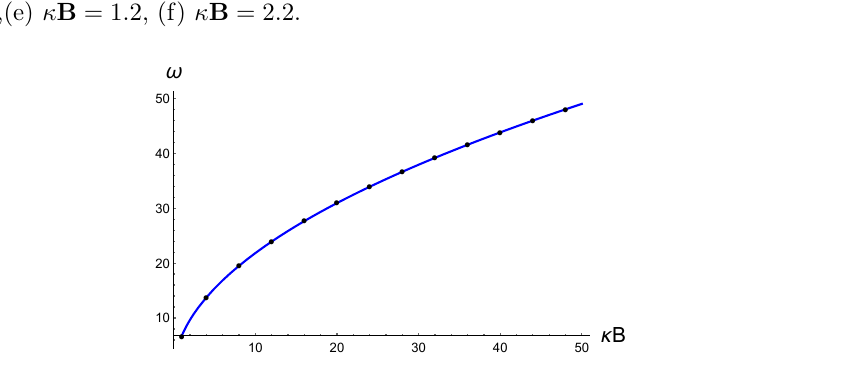
Figure 12. Location of the singularity as a function of (cid:20) B : numerical result (black dots) is best p (cid:12)tted by ! = (cid:0) 0 : 155157 + 6 : 95306 (cid:20) B (blue